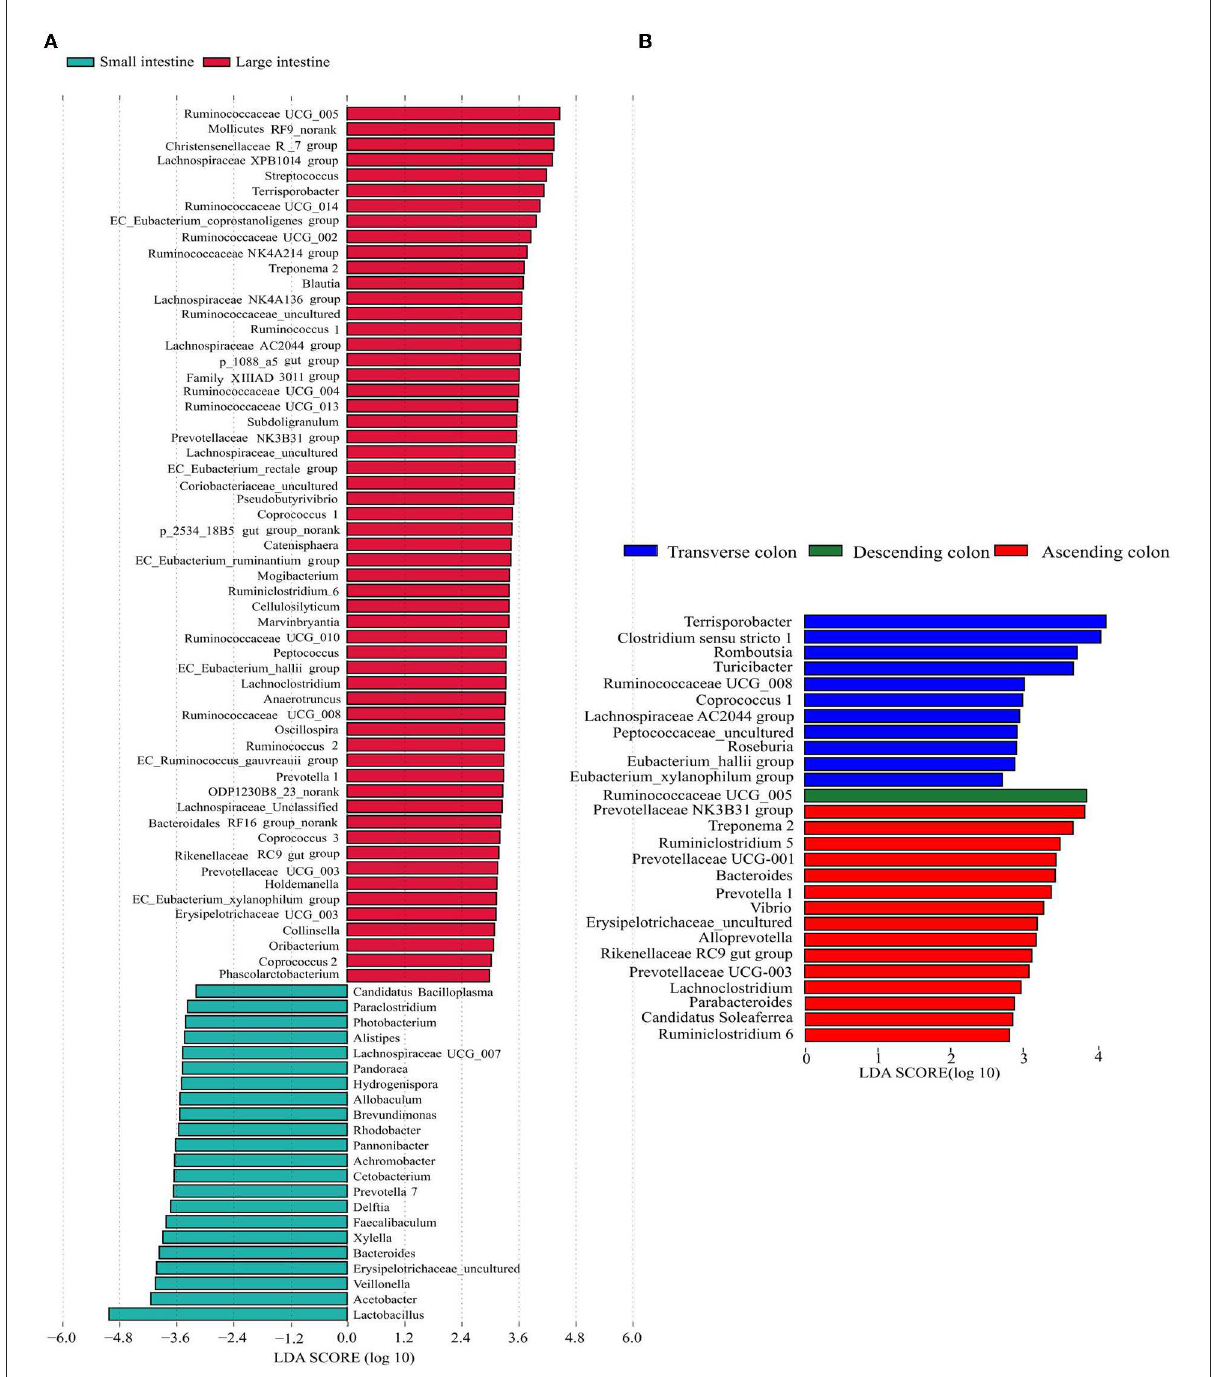
FIGURE4 Differentially represented genera in different intestinal locations of pigs identified by LEFSe using an LDA score threshold of > 2.5. (A) plots the discriminative genera enriched in the small and large intestine, (B) plots the discriminative genera enriched in different colon segments. The vertical axis represents the names of different genera, and the colors correspond to different intestinal locations.